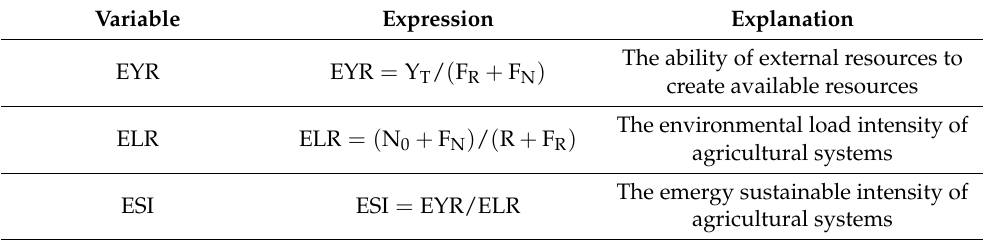
Table 3. Agricultural sustainability